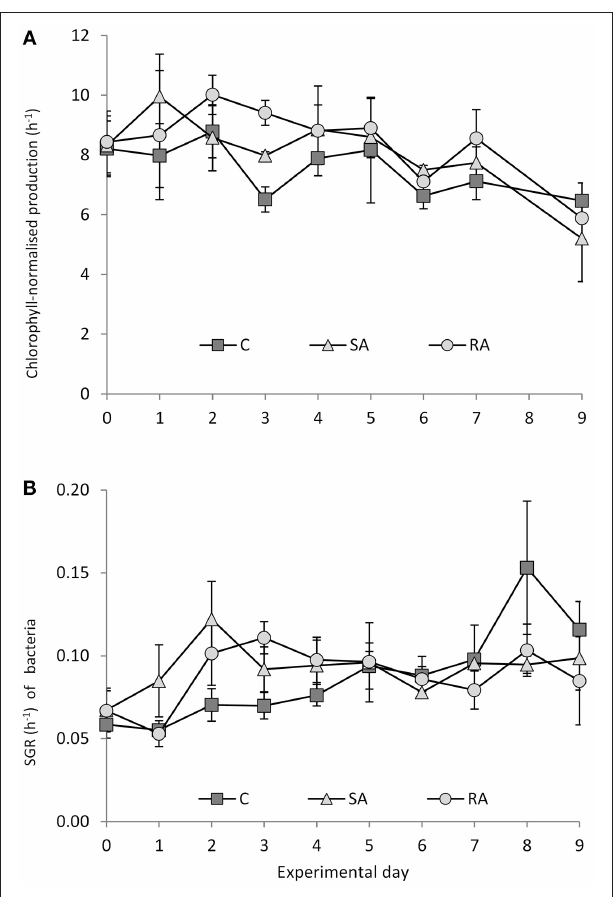
FIGURE 9 | (A) Chlorophyll-normalized production and (B) specific growth rate of bacteria during the mesocosm experiment. Cnt = Control mesocosms (no addition), SA = single addition, mesocosms where dust was added once, on the first day of the experiment, RA = repetitive addition, mesocosms where the same quantity of dust was added, divided into three doses, on the first 3 days of the experiment, Days 0, 1 and 2. Data are mean ± SD of 3 replicates. (A) is from Lagaria et al. (2017), this SI,